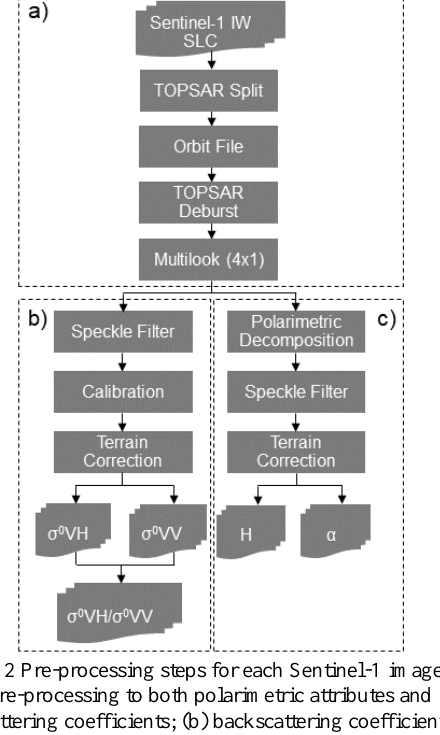
Figure 2 Pre-processing steps for each Sentinel-1 image: (a) pre-processing to both polarimetric attributes and backscattering coefficients; (b) backscattering coefficients; (c) polarimetric